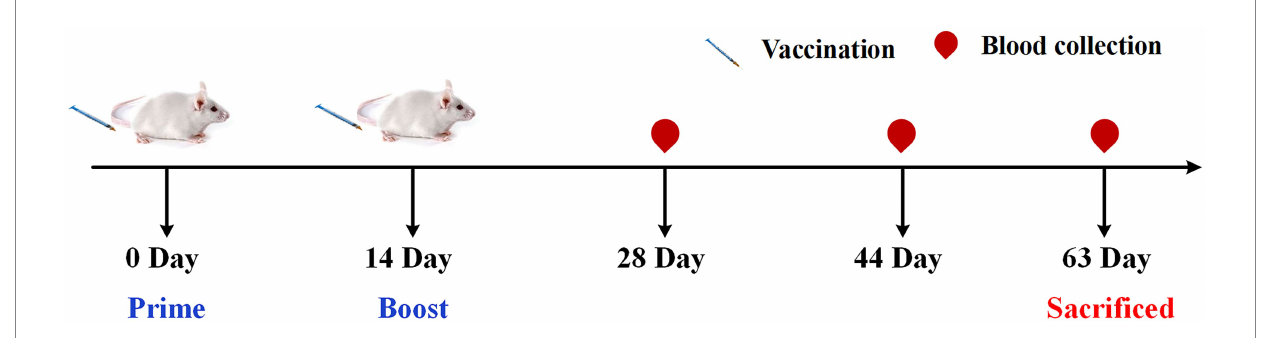
FIGURE 1 Schematic diagram of vaccination and sample collection.